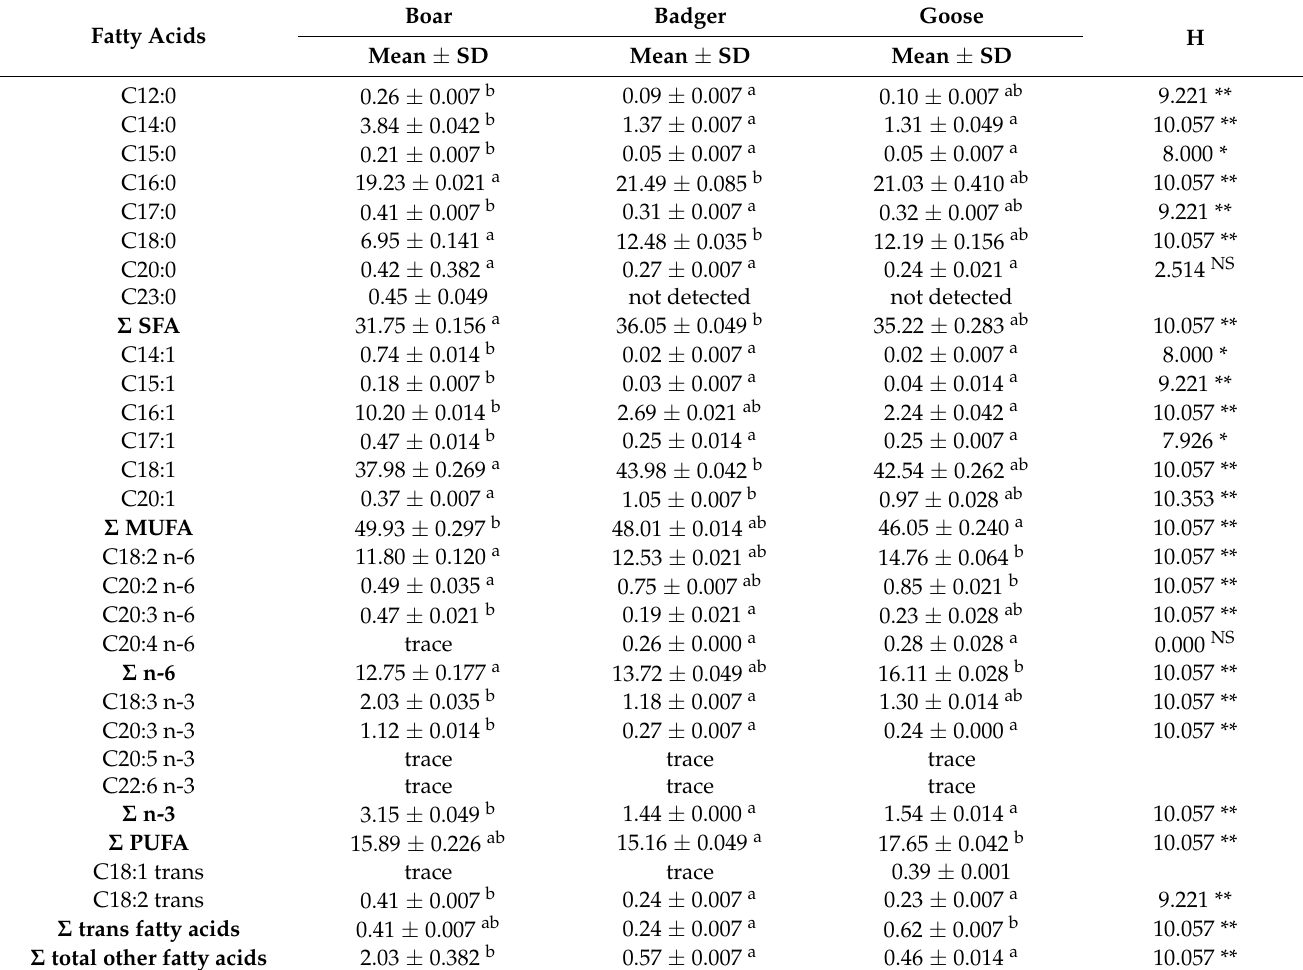
Table 1. The fatty acid profile of the adipose tissue-derived from wild animals (% of total fatty